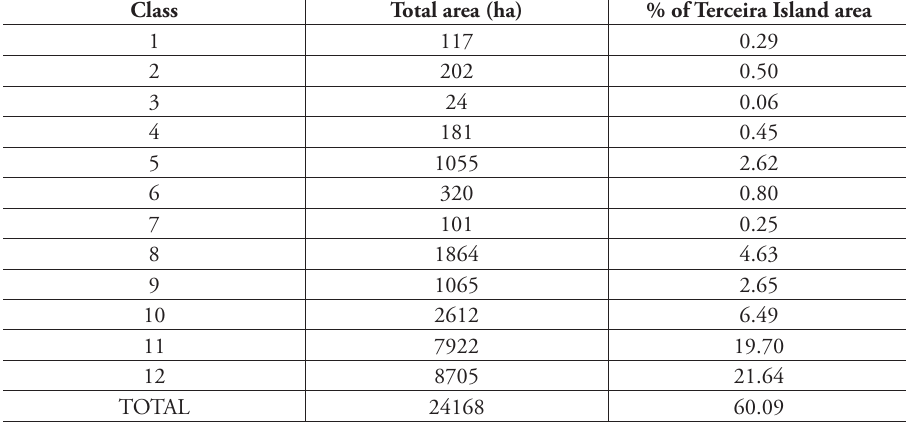
Table 5. Spatial assessment of insect pollinators’ richness classes in Terceira Island.